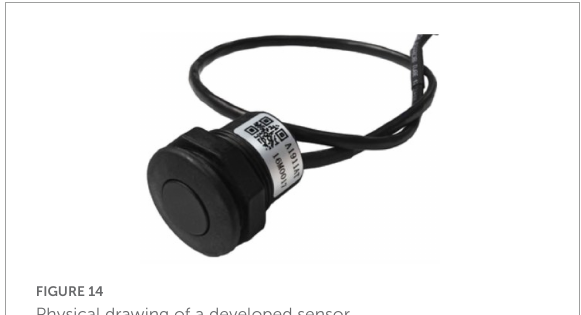
FIGURE14 Physical drawing of a developed